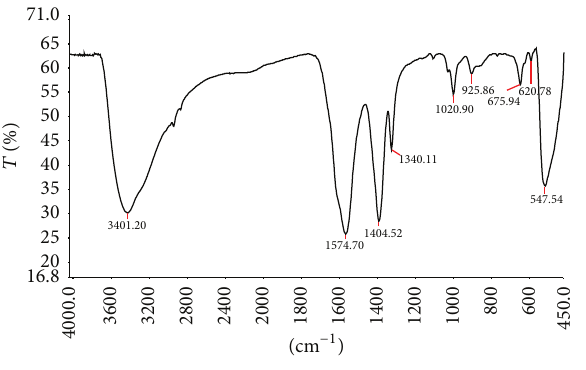
Figure 3: FTIR of ZnO nanoparticles.